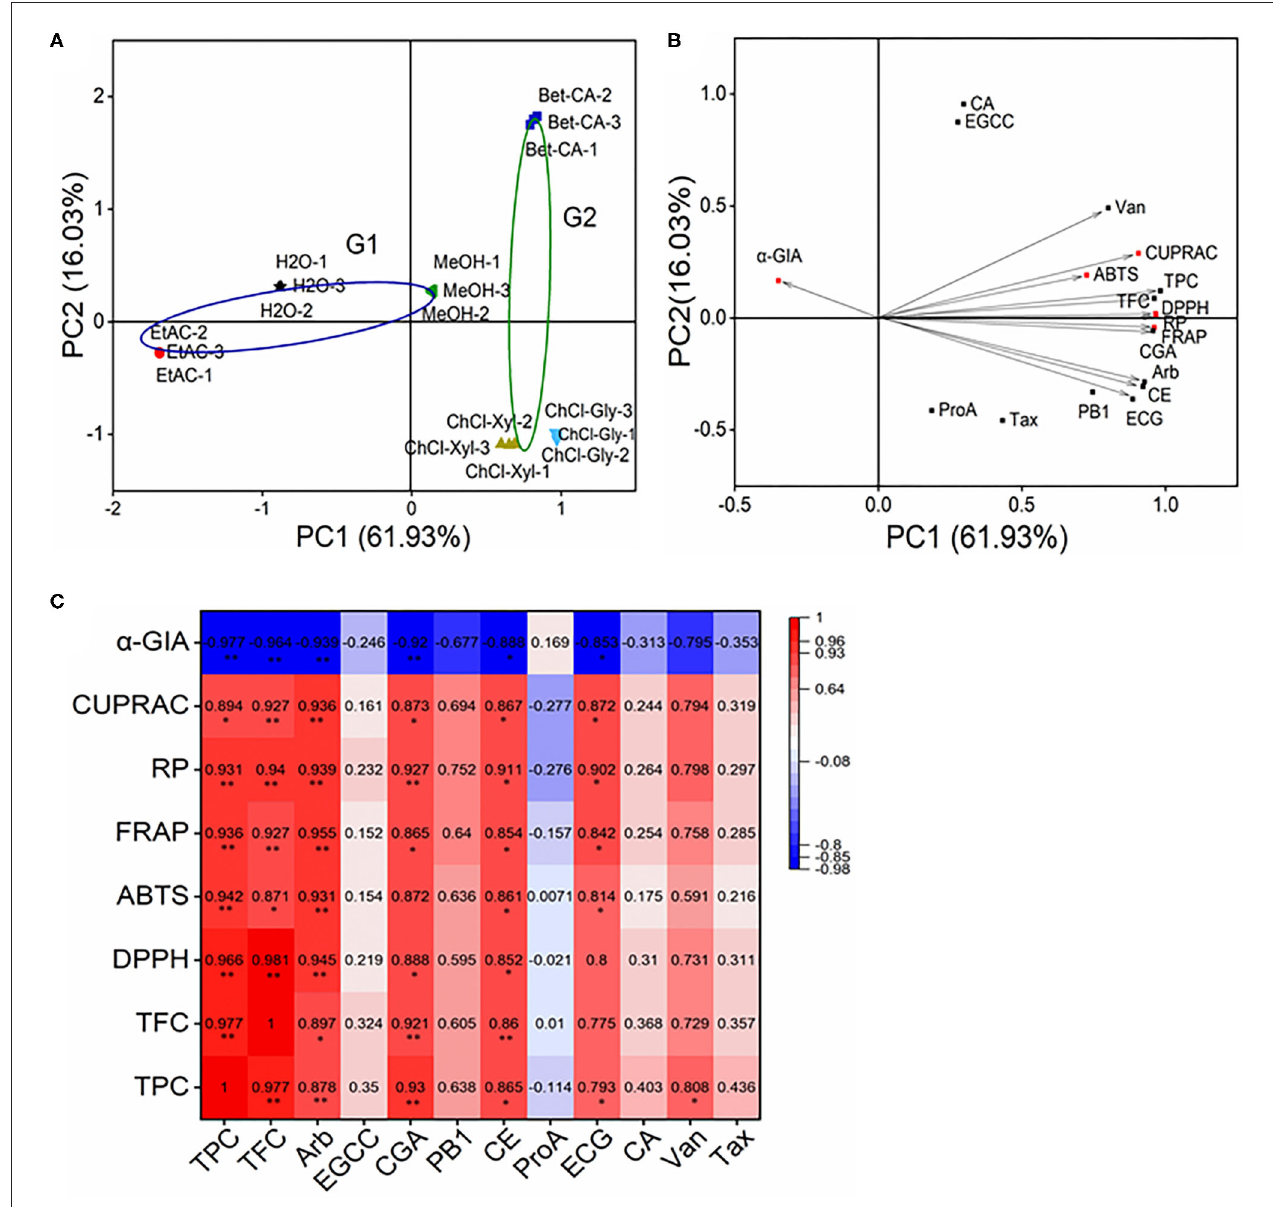
FIGURE 5 | Principal component analysis (PCA) and correlation matrix of CIOPs extracts. (A) , PCA score plot; (B) : PCA loading plot. (C) : Heatmap analysis of correlation matrix. Arb, arbutin; EGCC, (–)-epigallocatechin; CGA, chlorogenic acid; PB1, procyanidin B1; CE, ( + )-catechin; ProA, protocatechuic acid; ECG, epicatechin; CA, caffeic acid; Van, vanillin; Tax,